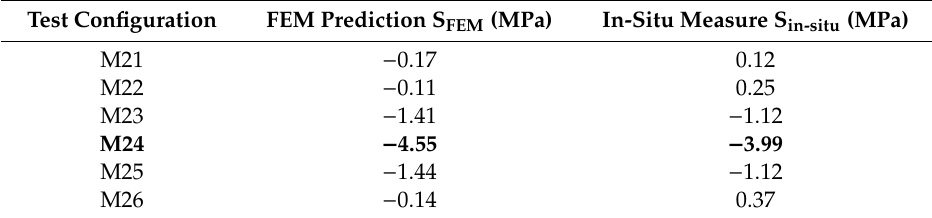
Table 6. Comparison of the in situ measured and estimated by means of FEM (for the backfill, having E = 200 MPa) stresses in t2 / 4 measuring point during the moving load tests (M21–M26). Test